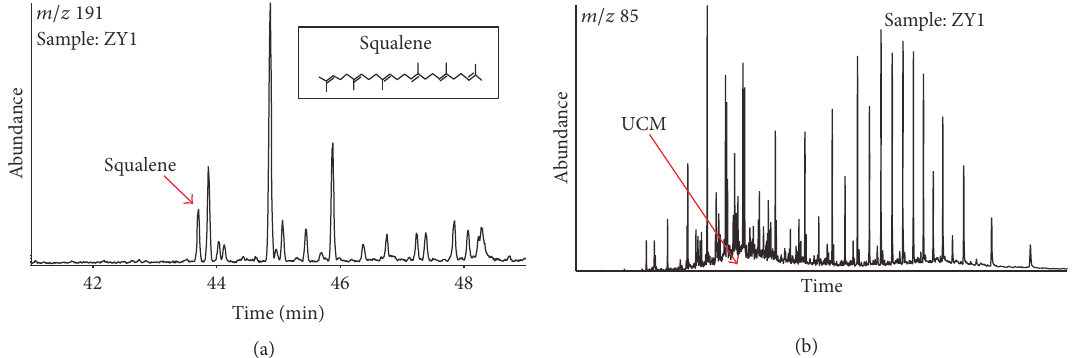
Figure 5: Biomarker characteristics of sediment core samples. (a) Generally contains squalene compound; (b) front peak group generally contains “UCM